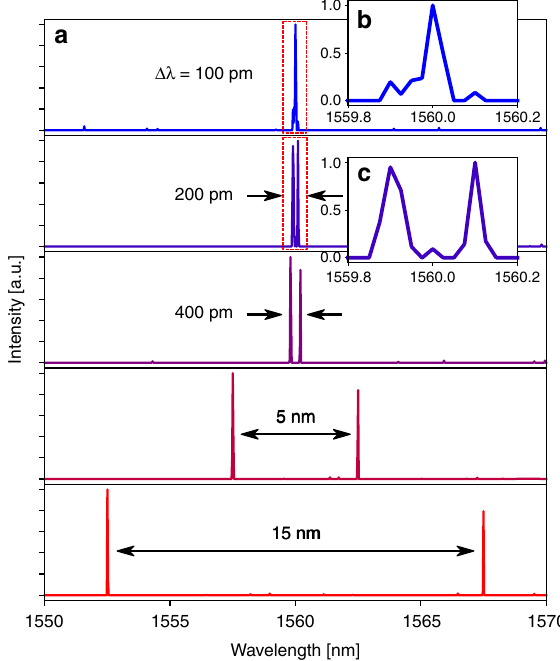
Fig. 3 Sparse signal reconstruction. a Spectra consisting of two laser lines with varying spacing measured using the 64-channel dFT spectrometer and reconstructed by applying the elastic-D 1 algorithm. Insets b and c show zoomed-in images of the narrow spectral features for input laser lines with 100 and 200 pm spacing, respectively